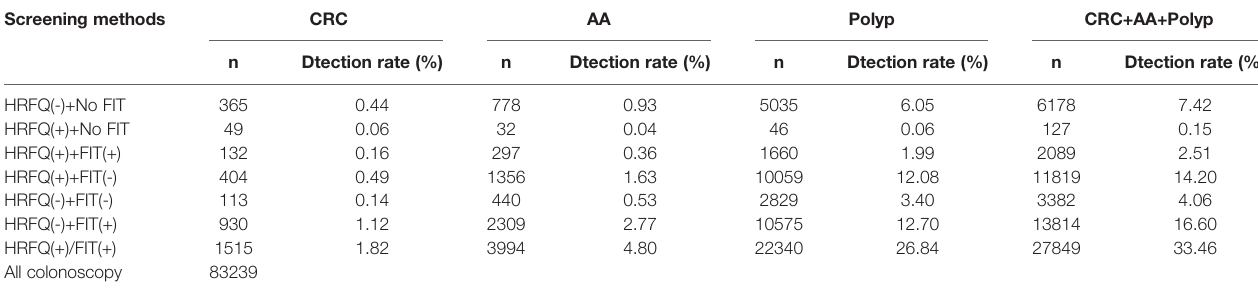
TABLE 9-5 | Comparison of colonoscopy results for different combinations of screening methods for HRFQ and FIT, (n, %). Screening